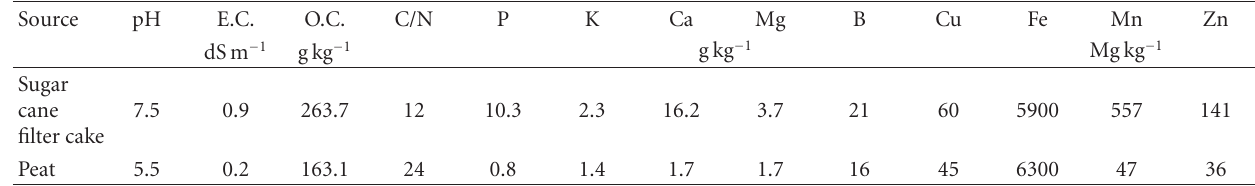
Table 1: Chemical composition of the organic materials ∗